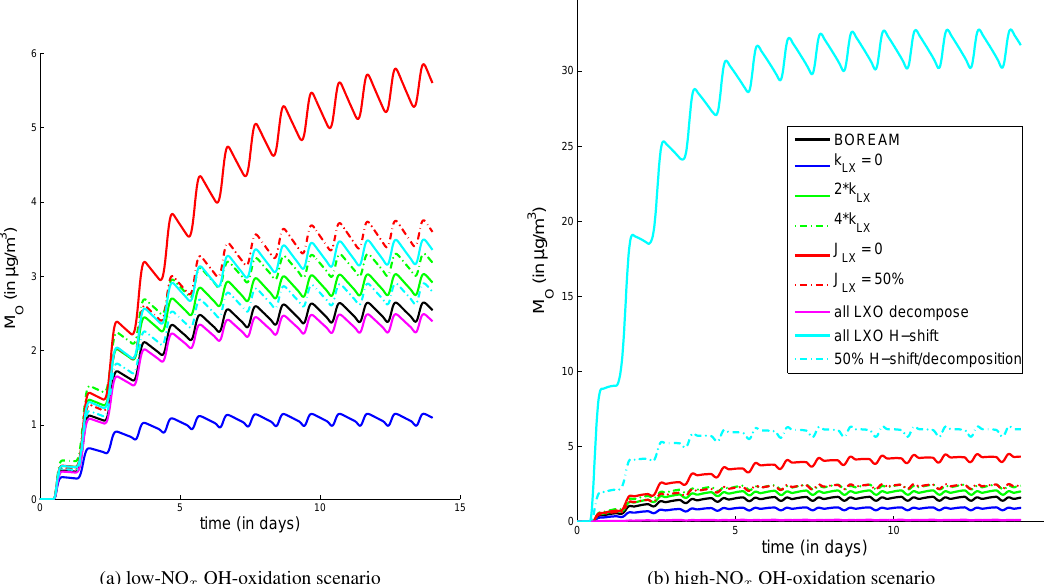
Fig. 9. Sensitivity tests for SOA yields to the assumed reaction constant with OH of the generic part of generic species classes, k LX , to the J-value j LXALD of this generic part and to the branching ratios of generic alkoxy radicals, similar to the tests shown in Fig. 2, for OH oxidation under (a) low (left panel) and (b) high-NO x conditions (right).